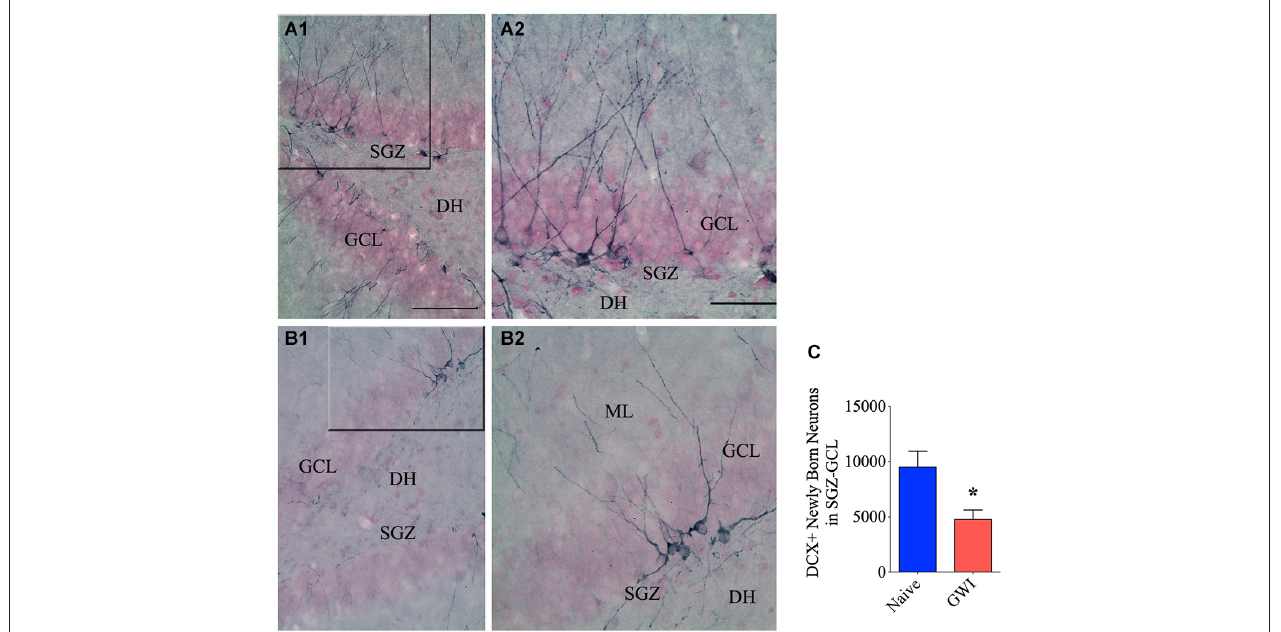
panels (A2) and (B2) are magnified views of marked regions from (A1) and (B1) showing the morphology of DCX+ newly born neurons. Scale bar (A1) and (B1) = 100 µ m; (A2) and (B2) = 50 µ m. DH, dentate hilus; ML, molecular layer. The bar chart (C) compares numbers of newly born (DCX+) neurons in the DG between naive control rats and rats exposed to GWIR-chemicals and stress. * p <